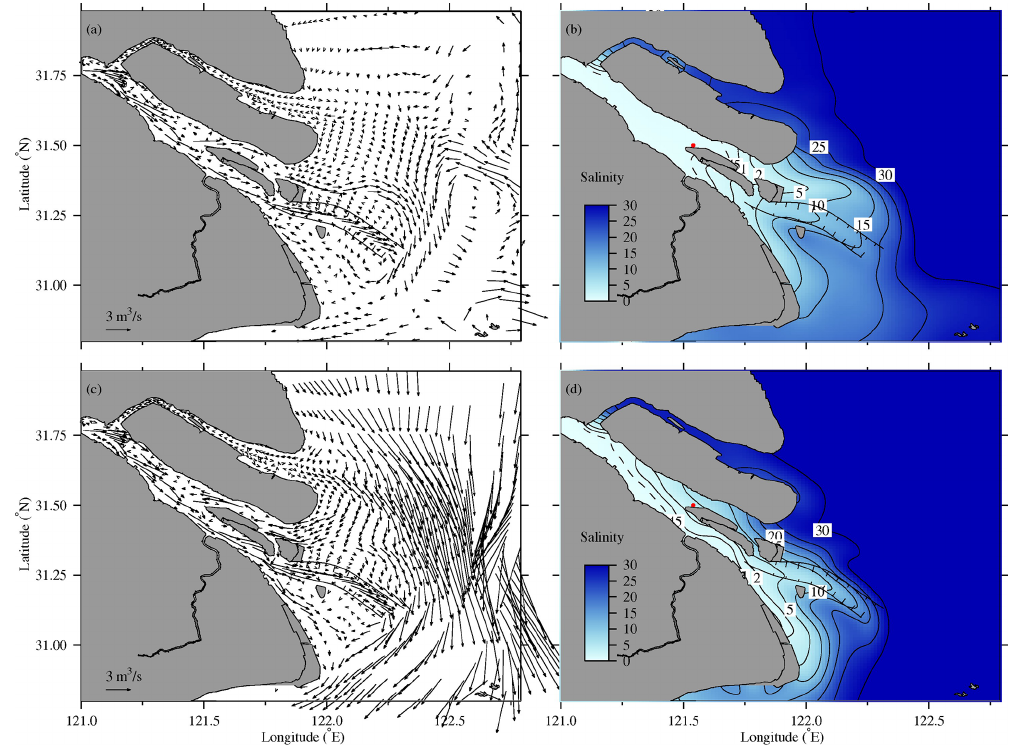
Figure 7. Distributions of residual unit width water flux (a, c) and time-averaged surface salinity (b, d) from 10 to 13 February 2014 and from experiment 1 (a, b) and experiment 2 (c, d) . The dashed isohaline represents a salinity of 0.45; the red dot denotes the location of water intake of Qingcaosha reservoir (similarly hereinafter).